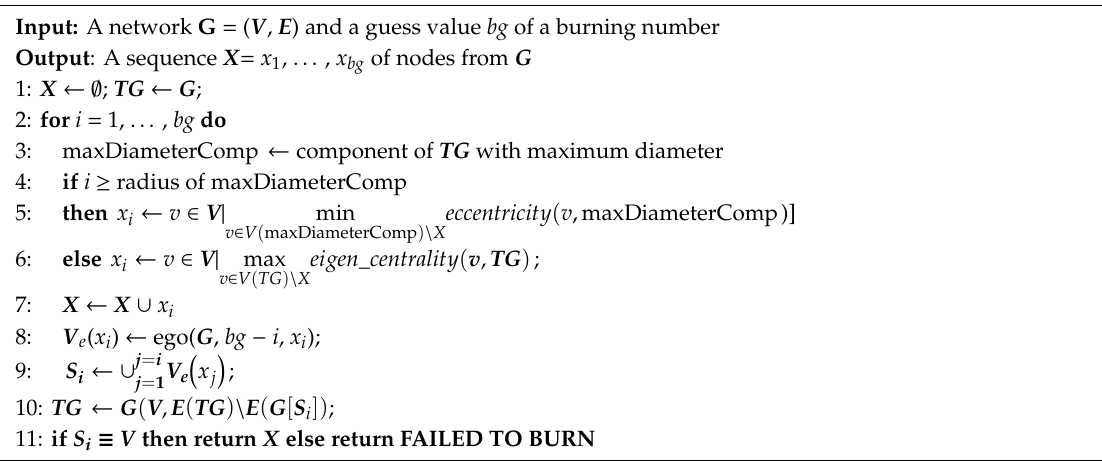
Algorithm 1. Maximum eigenvector centrality heuristic for a shortest burning